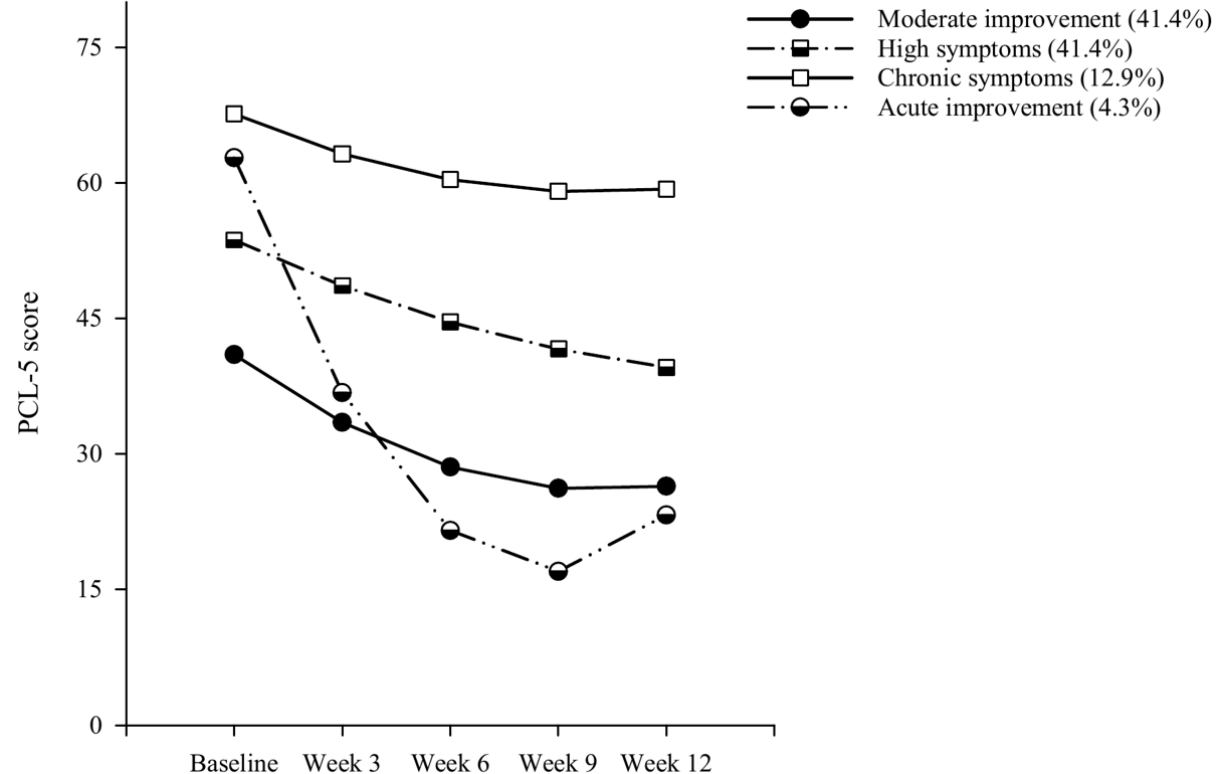
Figure 2. Estimated means for Muthén-Roy growth mixture modeling trajectories of PCL-5 symptom scores over 12 weeks of treatment (N=475).